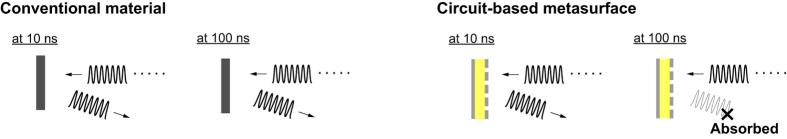
Image of time-varying response to continuous wave.Circuit-based metasurfaces studied here allow us to control their electromagnetic responses in accordance with the duration time of the incident wave, which is determined by their time constants. As a consequence, these structures behave as time-domain filters unlike conventional circuit filters, which behave differently in response to the difference in frequency spectrum.